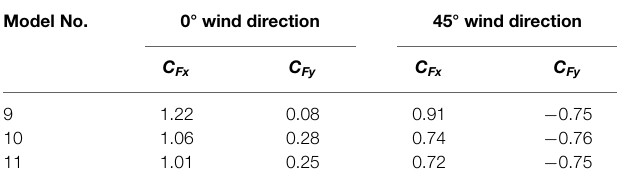
TABLE 5 | Modified corner